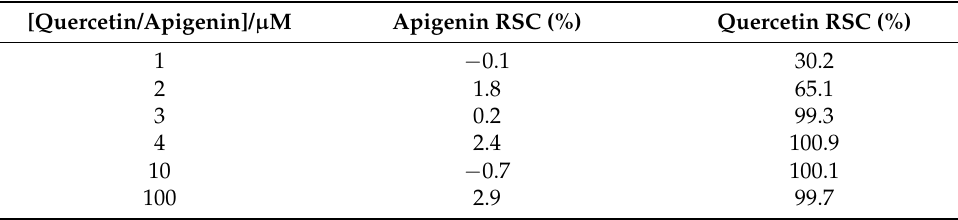
Table 7. Radical scavenging capacity (RSC, in %) of apigenin and quercetin, determined by their ability to quench the absorbance of the DPPH radical.